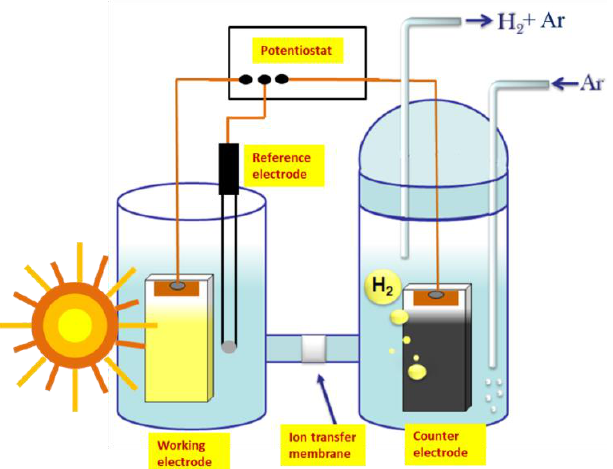
Figure 1. Schematic representation of the reactor employed in the present work, showing the working electrode (photoanode), counter electrode (cathode electrode carrying an electrocatalyst), reference electrode, and connections with a potentiostat, which provides the necessary bias. Hydrogen production is monitored in a de-aerated environment obtained by Ar flow.